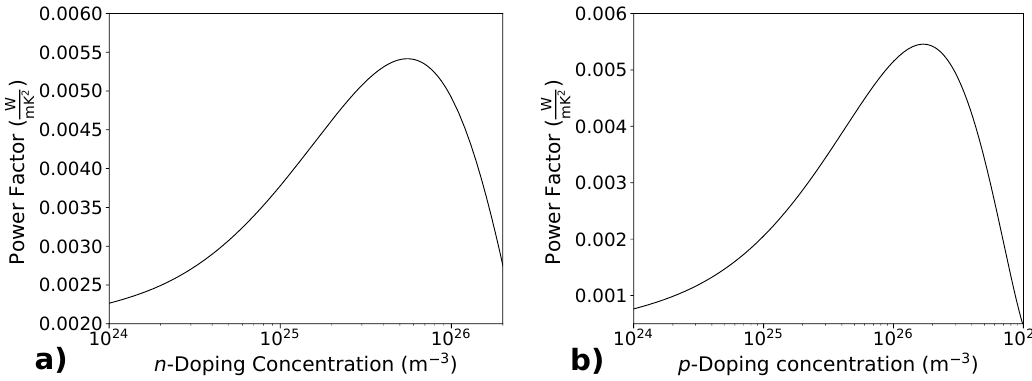
Figure 2. The room temperature power factor S 2 σ is reported as a function of the doping concentration, both for n (Panel ( a )) and for p type silicon (Panel ( b )). An optimal doping for the maximum power factor is established both for n ( n = 5.5 × 10 25 m − 3 ) and for p ( p = 1.2 × 10 26 m − 3 ) type silicon. Panel ( a ) has been reprinted from [14] with